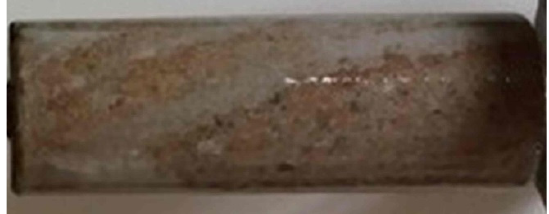
Figure 8. Wash contact time of 6 min.